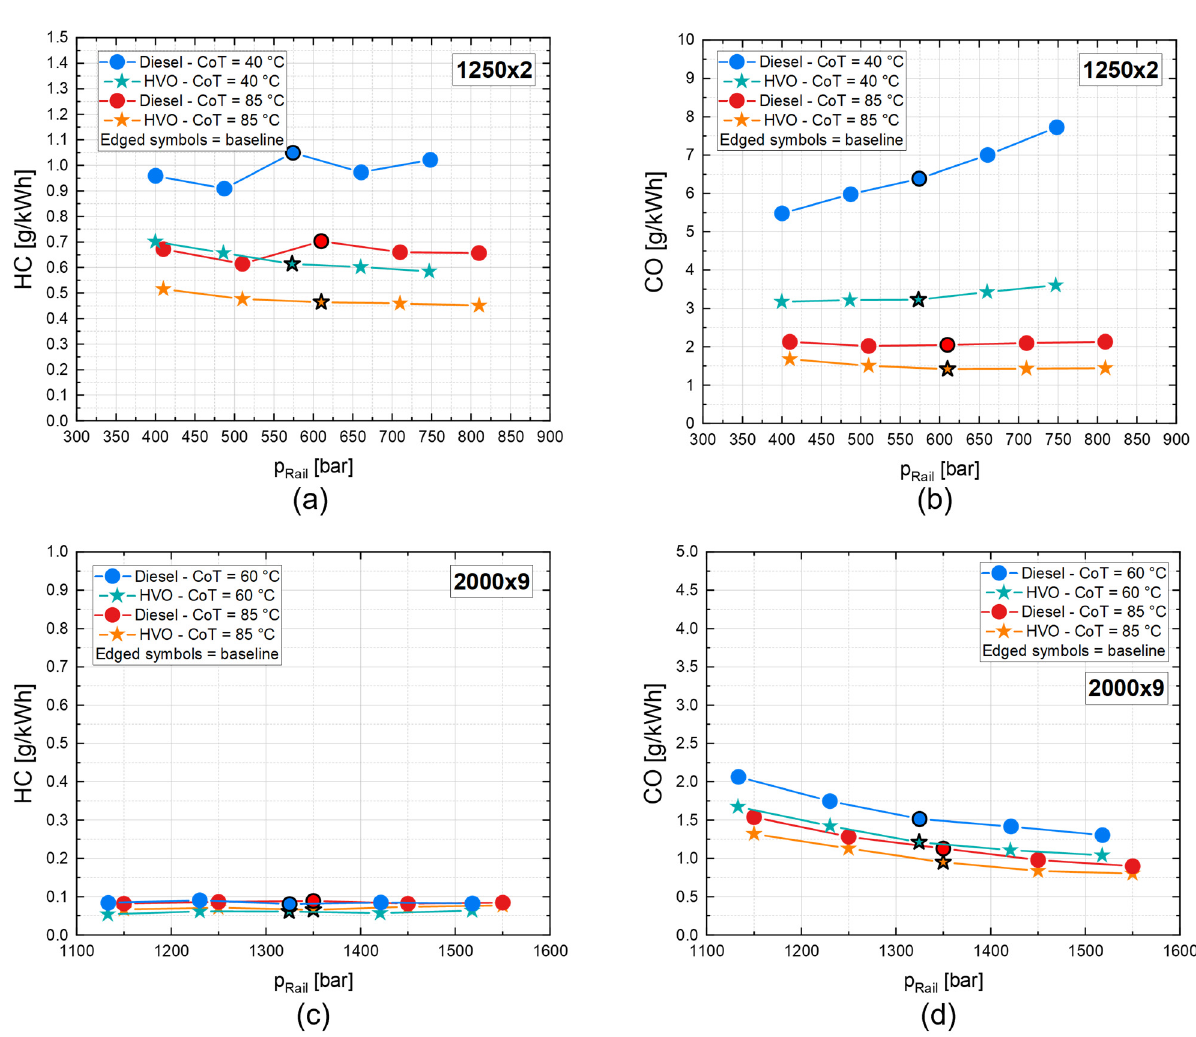
Figure 11. HC and CO emissions along p Rail sweep tests at 1250 × 2 ( a , b ) and 2000 × 9 ( c , d ). Comparison between diesel and HVO at high and low coolant temperatures. Warm colors represent high coolant temperatures, while cool colors represent low coolant temperatures. Circles represent diesel, while stars represent HVO.